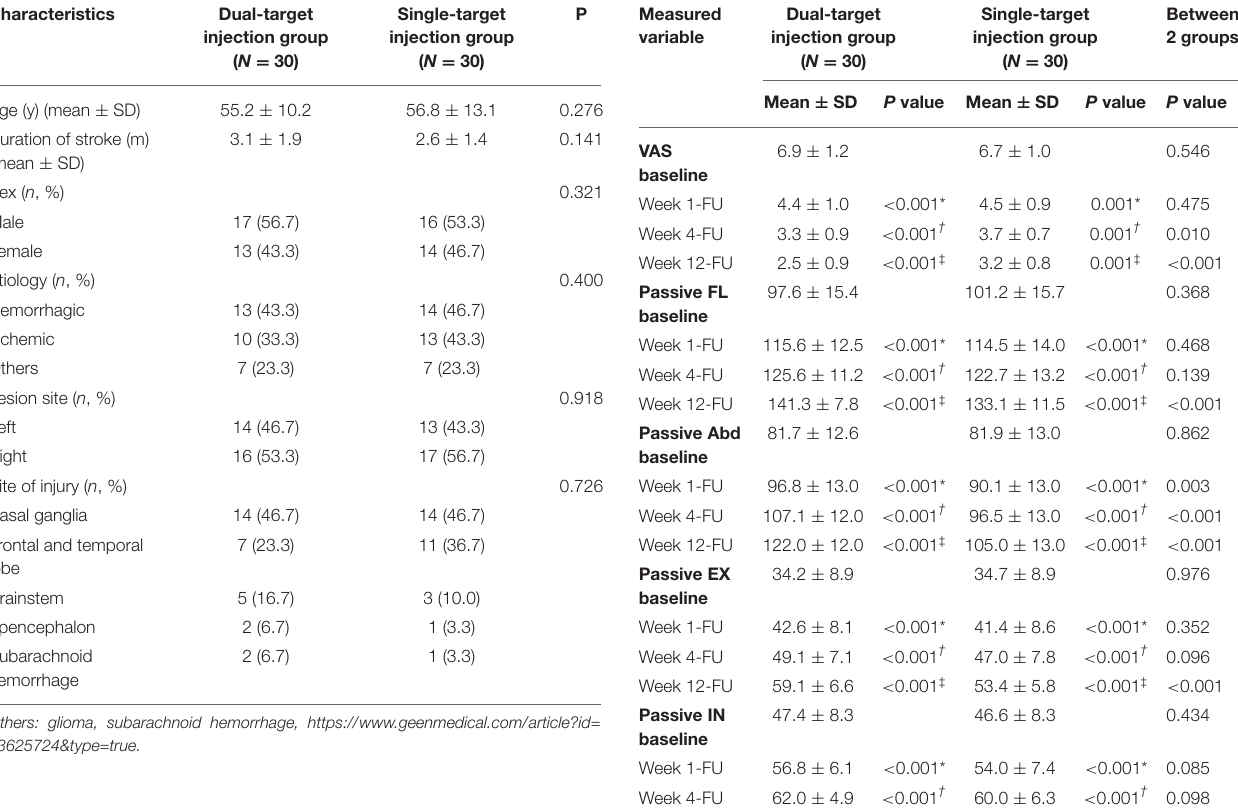
injection group